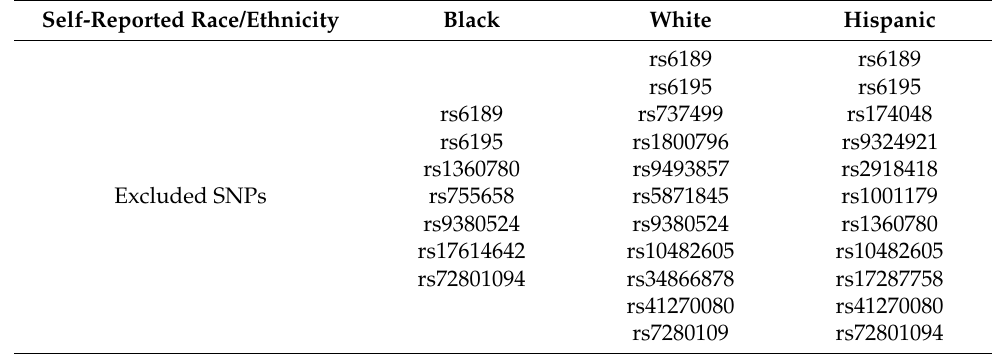
Table A3. SNPs removed from analysis.